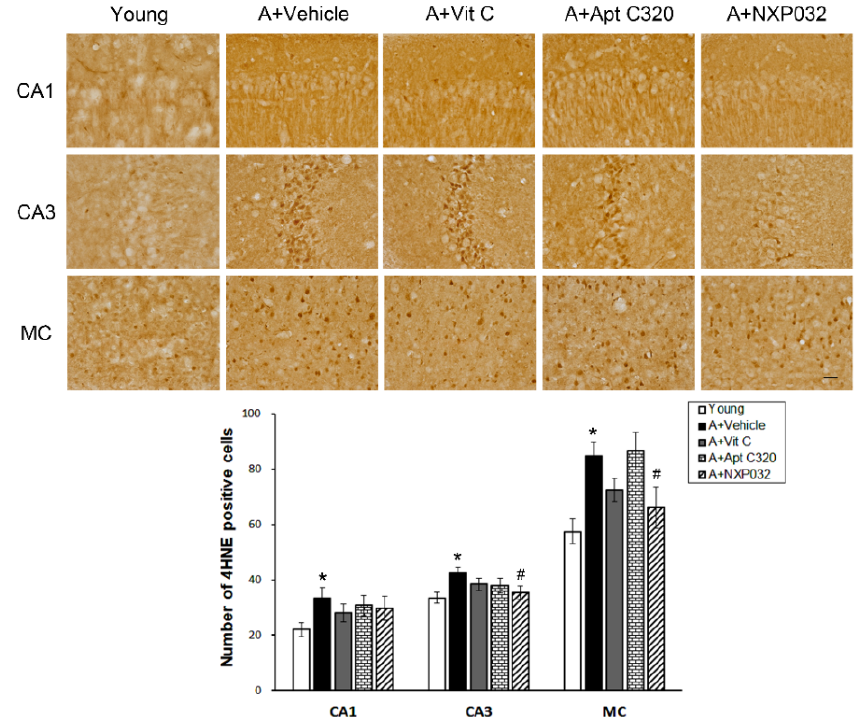
Figure 5. Effect of NXP032 on aging-induced 4HNE production in the hippocampal CA1, CA3, and MC regions. Representative photographs of 4HNE immunostaining in the hippocampal CA1, CA3, and MC regions. The aging mice had a significantly higher number of 4HNE in the hippocampal CA1, CA3, and MC regions. NXP032-treated mice had a significantly reduced number of 4HNE in the hippocampal CA3, and MC regions than in the vehicle-treated mice. In the vit C and Aptamin 320-treated groups, the number of 4HNE did not decrease in hippocampal CA1, CA3, and MC regions. The data are presented as the mean ± S.E.M. * p < 0.05, compared to the young group. # p < 0.05, compared to the aging-vehicle group. Scale bar: 50 µm.